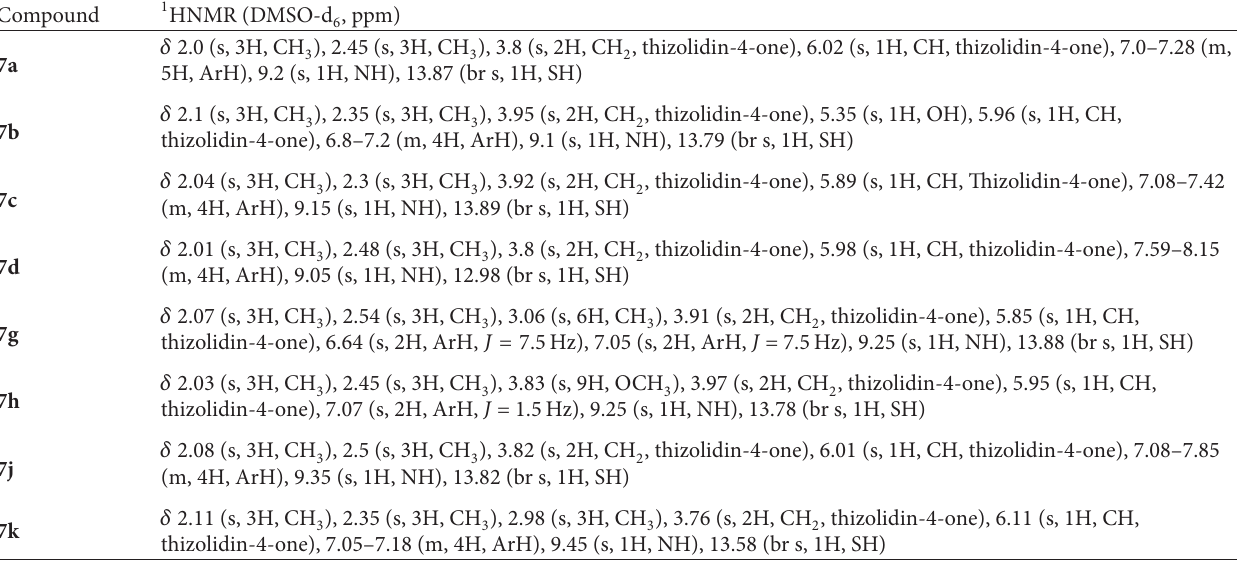
T 2: 1 HNMR spectral data of